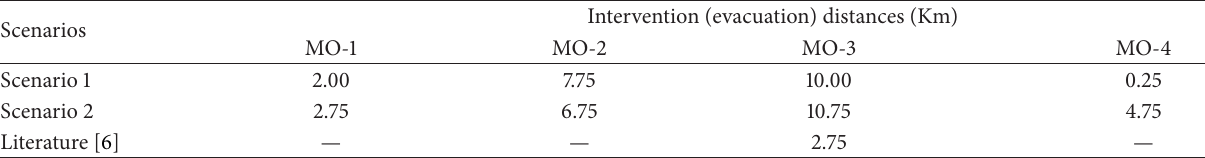
Table 1: Evacuation intervention distance for different MET